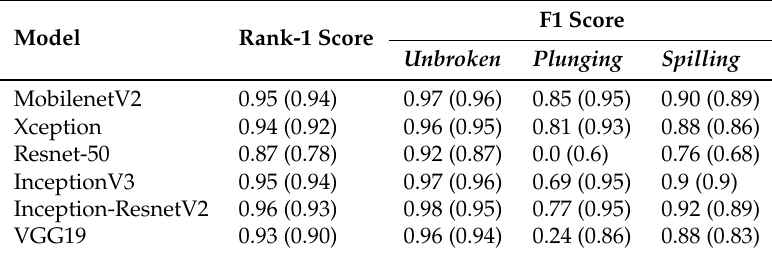
Table 1. CNN classification results. Rank-1 and F1 scores for each of six models without (and with) image